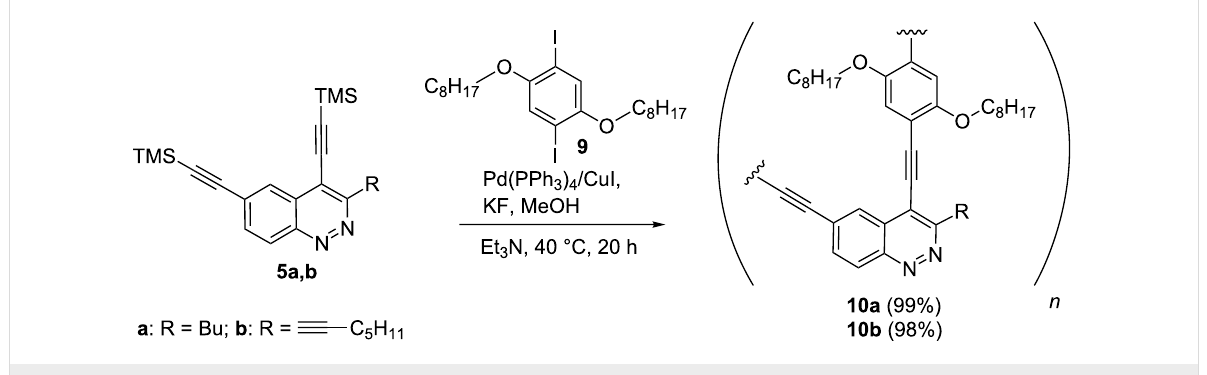
Scheme 1: Synthesis of cinnoline-containing PAEs 10a,b